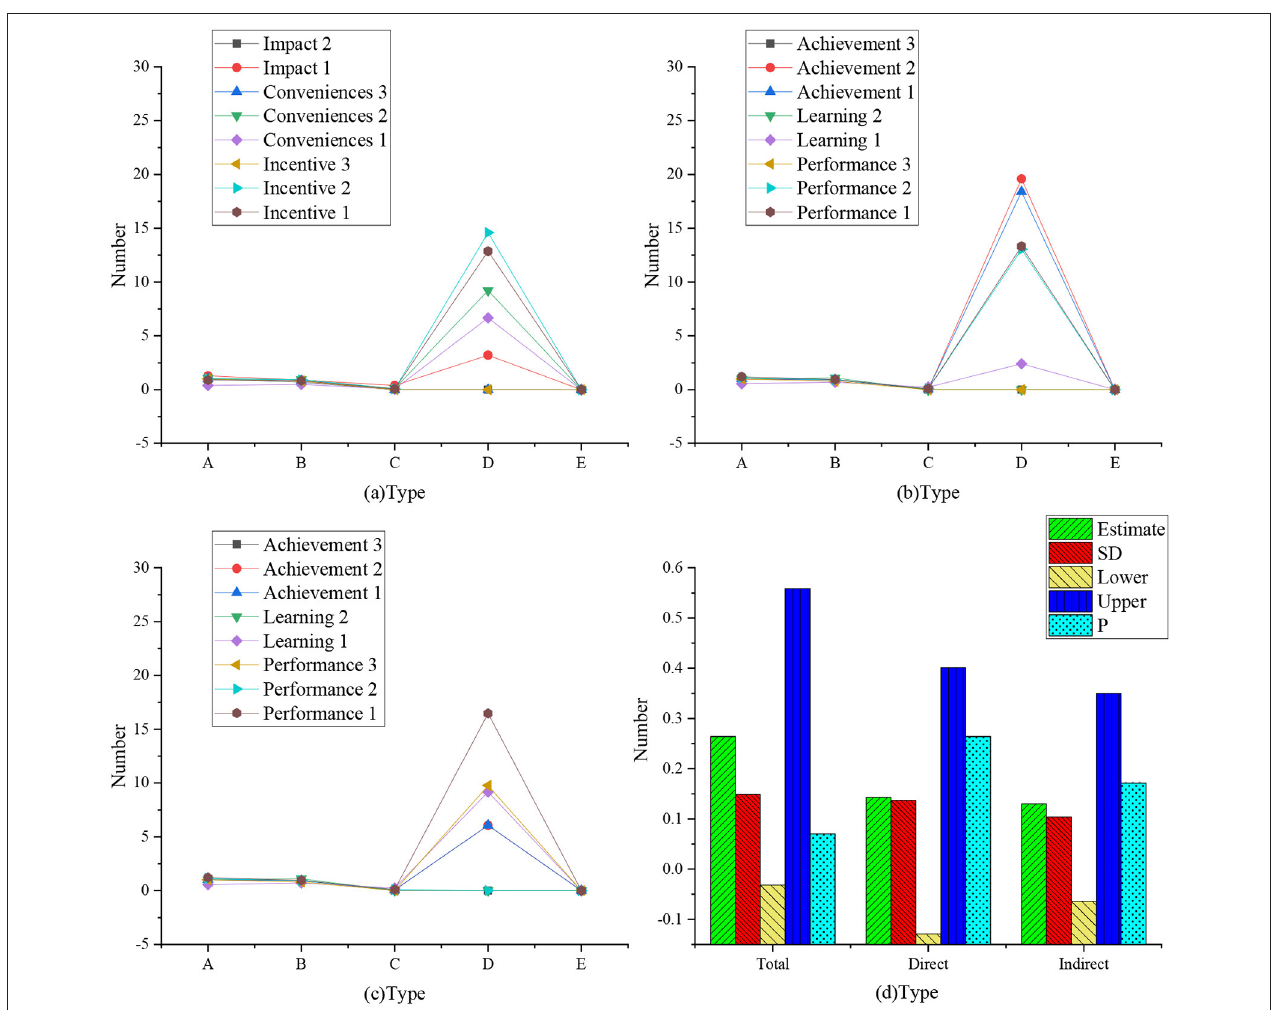
FIGURE 11 | Regression weights before the merger ( a : regression weight of influencing, incentive, and convenience factors; b : regression weight of learning, performance, and achievement factors; c : regression weight of trust, satisfaction, and reuse factors; d : arbitration analysis before the merger; A: non-standard; B: standardized C: SE value; D: T -value; E: P